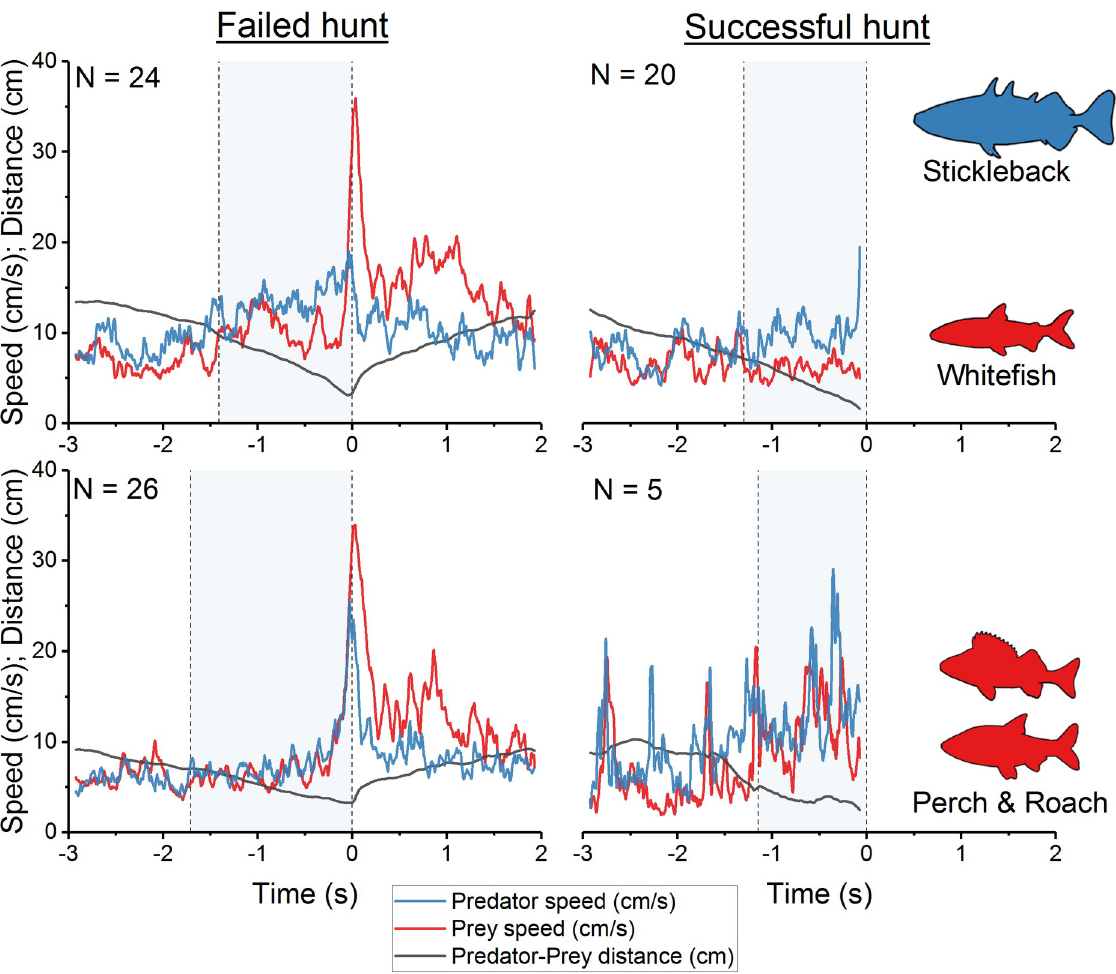
Fig 5. Predator and prey tracks before and after an unsuccessful hunt and before a successful hunt. The biting attempt of the predator was at time = 0 s. Tracks were divided into two prey fish categories (whitefish, and roach & perch). The speed in cm/s and distance in cm was derived from smoothed 3D tracks of prey and predators. Tracks were averaged over each species and outcome category. The grey-coloured period of predation describes the hunt of the stickleback.